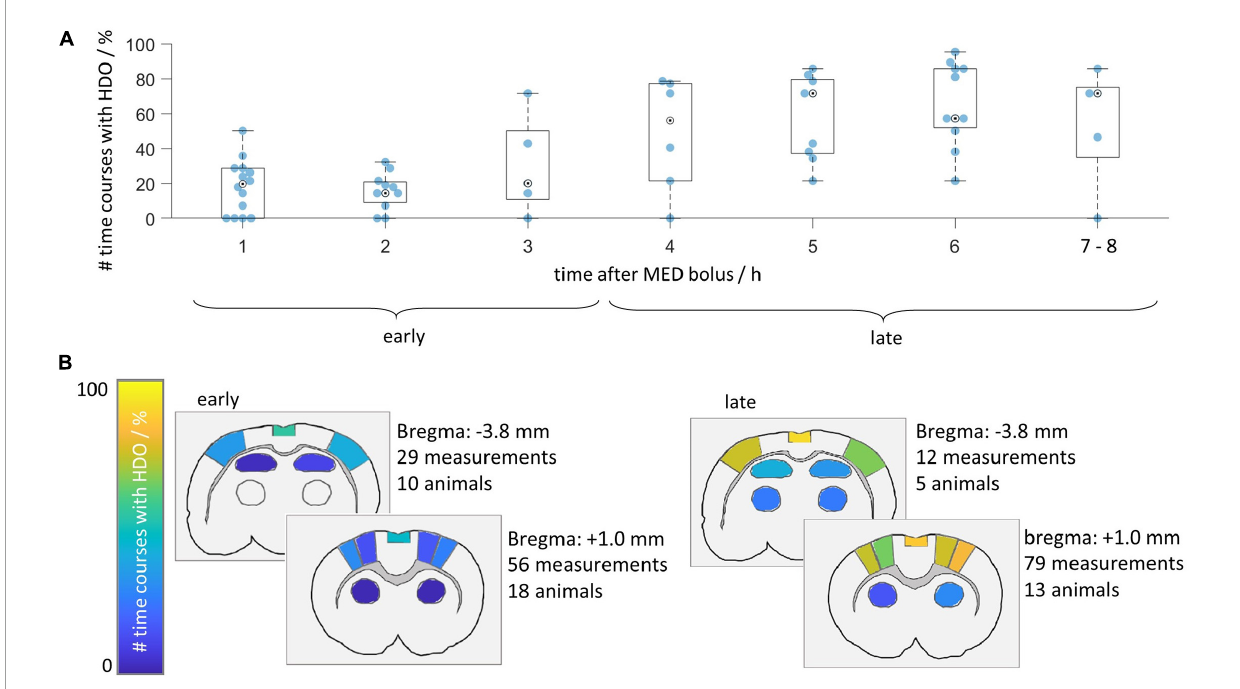
FIGURE5 Hemodynamic oscillations prevalence increases over time. HDO prevalence was assessed in 135 GE-EPI scans of 23 animals measured after switching from ISO to MED anesthesia. (A) Time line illustrating relative prevalence of HDO. For each animal, all measurements acquired within 1 h were combined and the percentage of oscillating signal time courses was plotted. Not every animal was measured at all time points. Measurements recorded after more than 6 h were displayed together. (B) HDO prevalence maps separated into early (recorded 1–3 h after MED start) and late (recorded 4 h or later) measurements. Color codes relative number of scans with HDO in each of the 14 brain regions.